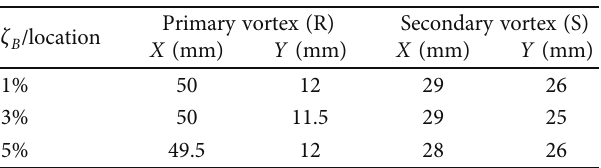
Figure 5: Cold-state time-averaged fl ow fi elds at section P0 under di ff erent conditions: (a) ζ Table 4: The vortex center location of the primary vortex and secondary